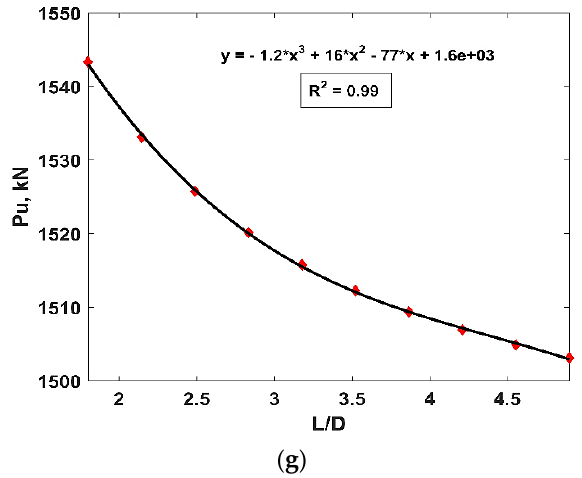
Figure 9. Parametric analysis of input variables. ( a ) Outer diameter of steel tube (D), ( b ) wall thickness of steel tube (t), ( c ) compressive strength of concrete (f c ’), ( d ) yield strength of steel (f y ), ( e ) length of column, (L), ( f ) confinement factor ( ζ ), ( g ) ratio of L/D.